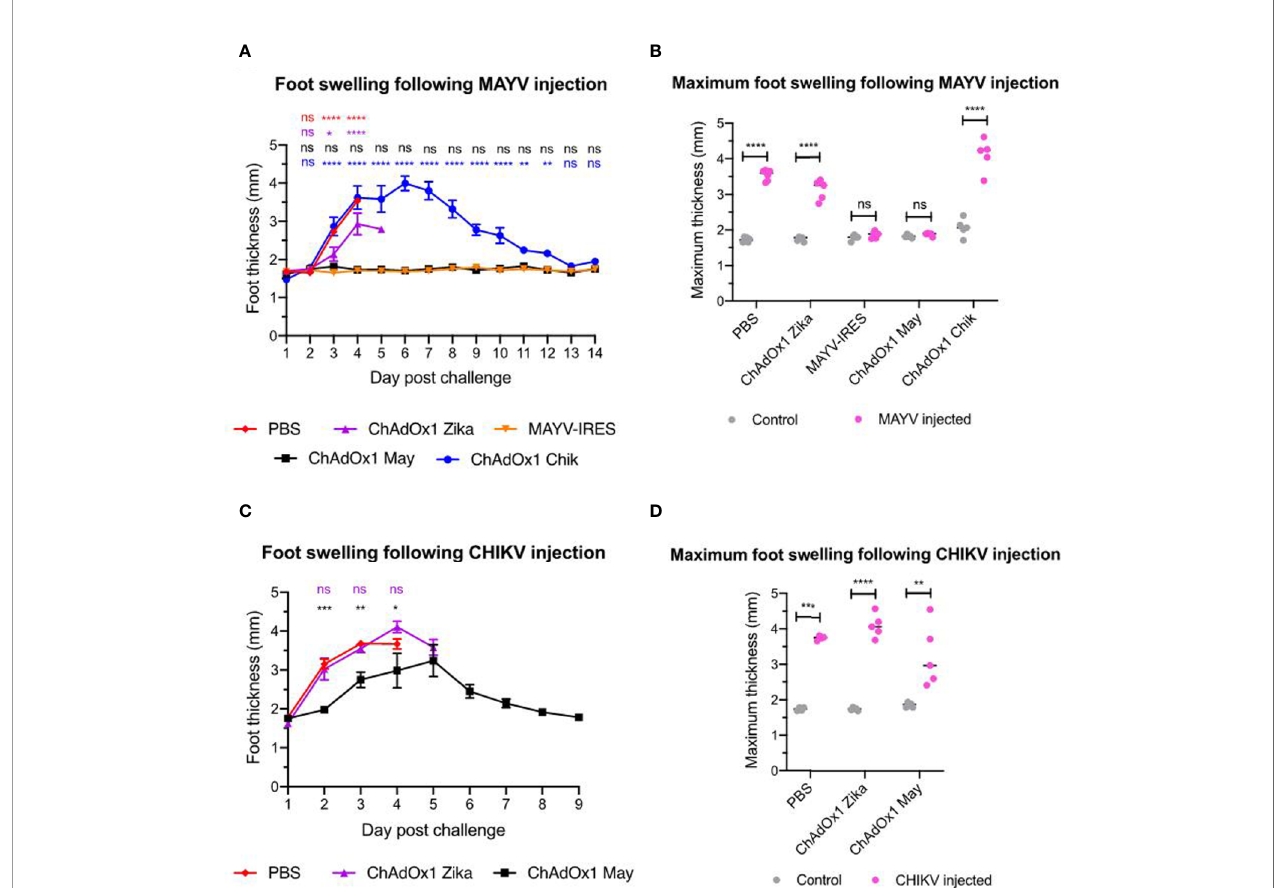
FIGURE 5 | ChAdOx1 May but not ChAdOx1 Chik provides some cross-protection against foot swelling. (A) Foot thickness (in mm) at the Mayaro virus (MAYV) injection site. Data represented as mean and SEM, restricted maximum likelihood mixed model with Dunnett ’ s (compared with MAYV-IRES group). (B) Comparison between control foot (in grey) and the maximum foot thickness (in pink) at any given timepoint following MAYV injection. Dots represent each mouse, two-way ANOVA with Sidak ’ s. (C) Data represented as mean and SEM, restricted maximum likelihood mixed model with Dunnett ’ s (compared with PBS group). (D) Comparison between control foot (in grey) and the maximum footpad thickness (in pink) at any given timepoint following CHIKV injection. Dots represent each mouse, two-way ANOVA with Sidak ’ s. *p < 0.05, **p < 0.01, ***p < 0.001, ****p < 0.0001. ns, not signi fi